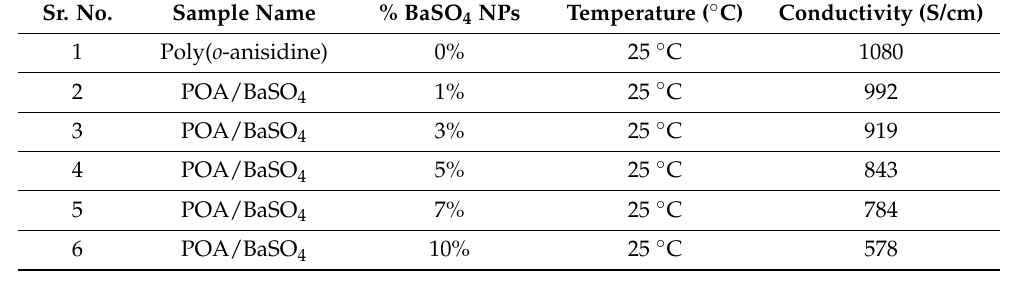
Table 2. Scheme of conductivity test. Sr. No.